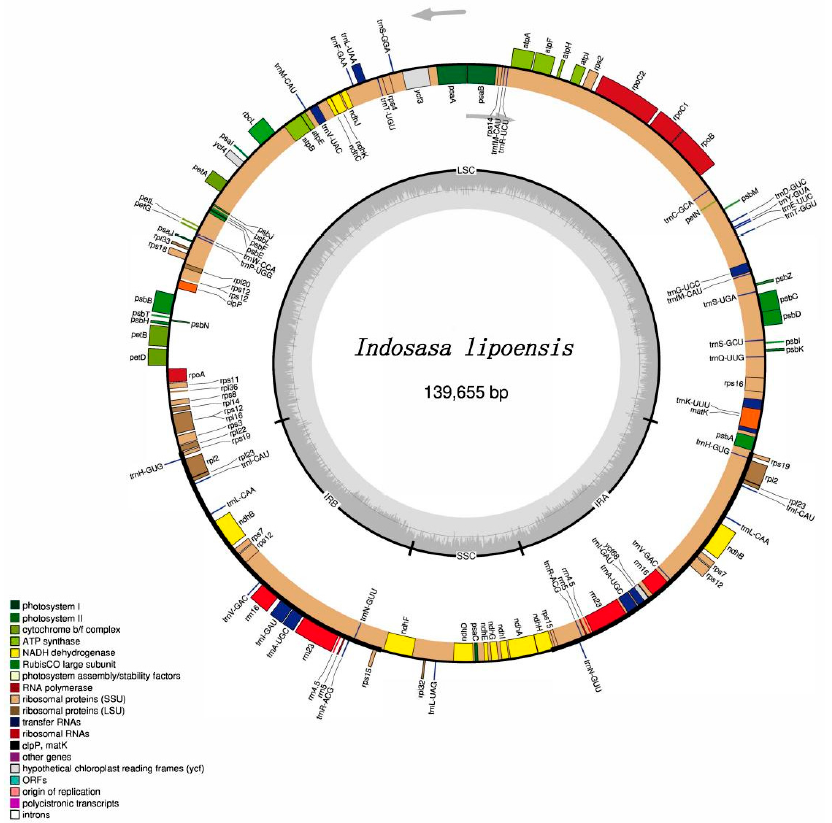
Figure 1. The gene map of the cp genome of Indosasa lipoensis . Genes outside of the circle are tran- scribed in the counterclockwise direction, and those within the circle are transcribed in the clockwise direction. Table 1. Annotated list of genes identified within the cp genome of Indosasa lipoensis.